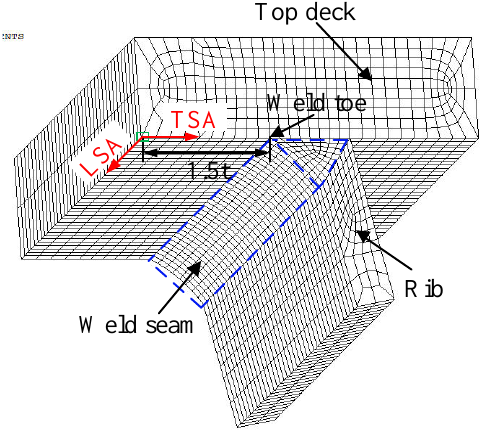
Figure 11. Direction and location of the external cyclic loading (transverse stress amplitude (TSA) and longitudinal stress amplitude (LSA)).